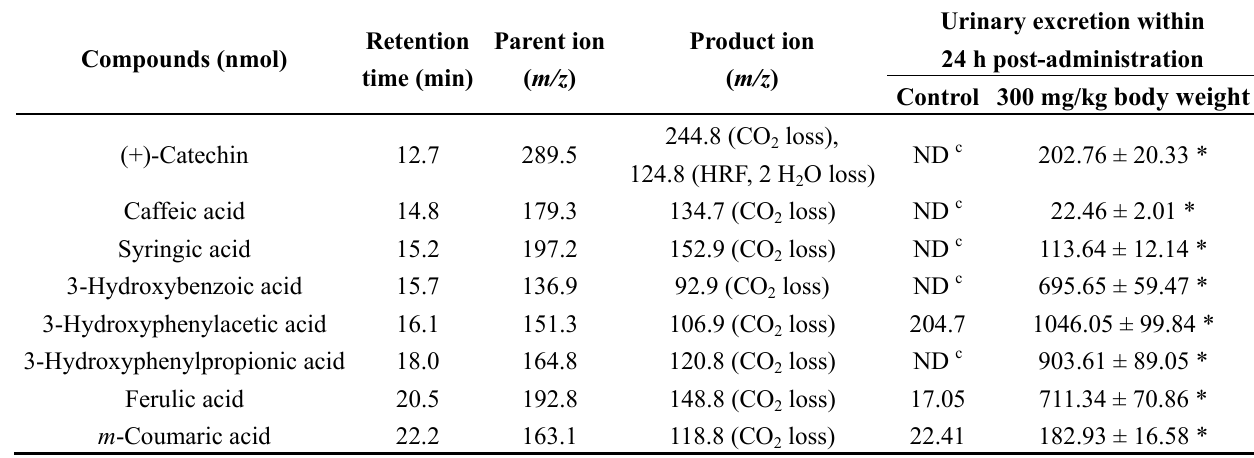
Table 1. Metabolites excreted in urine within 24 h post-administration.